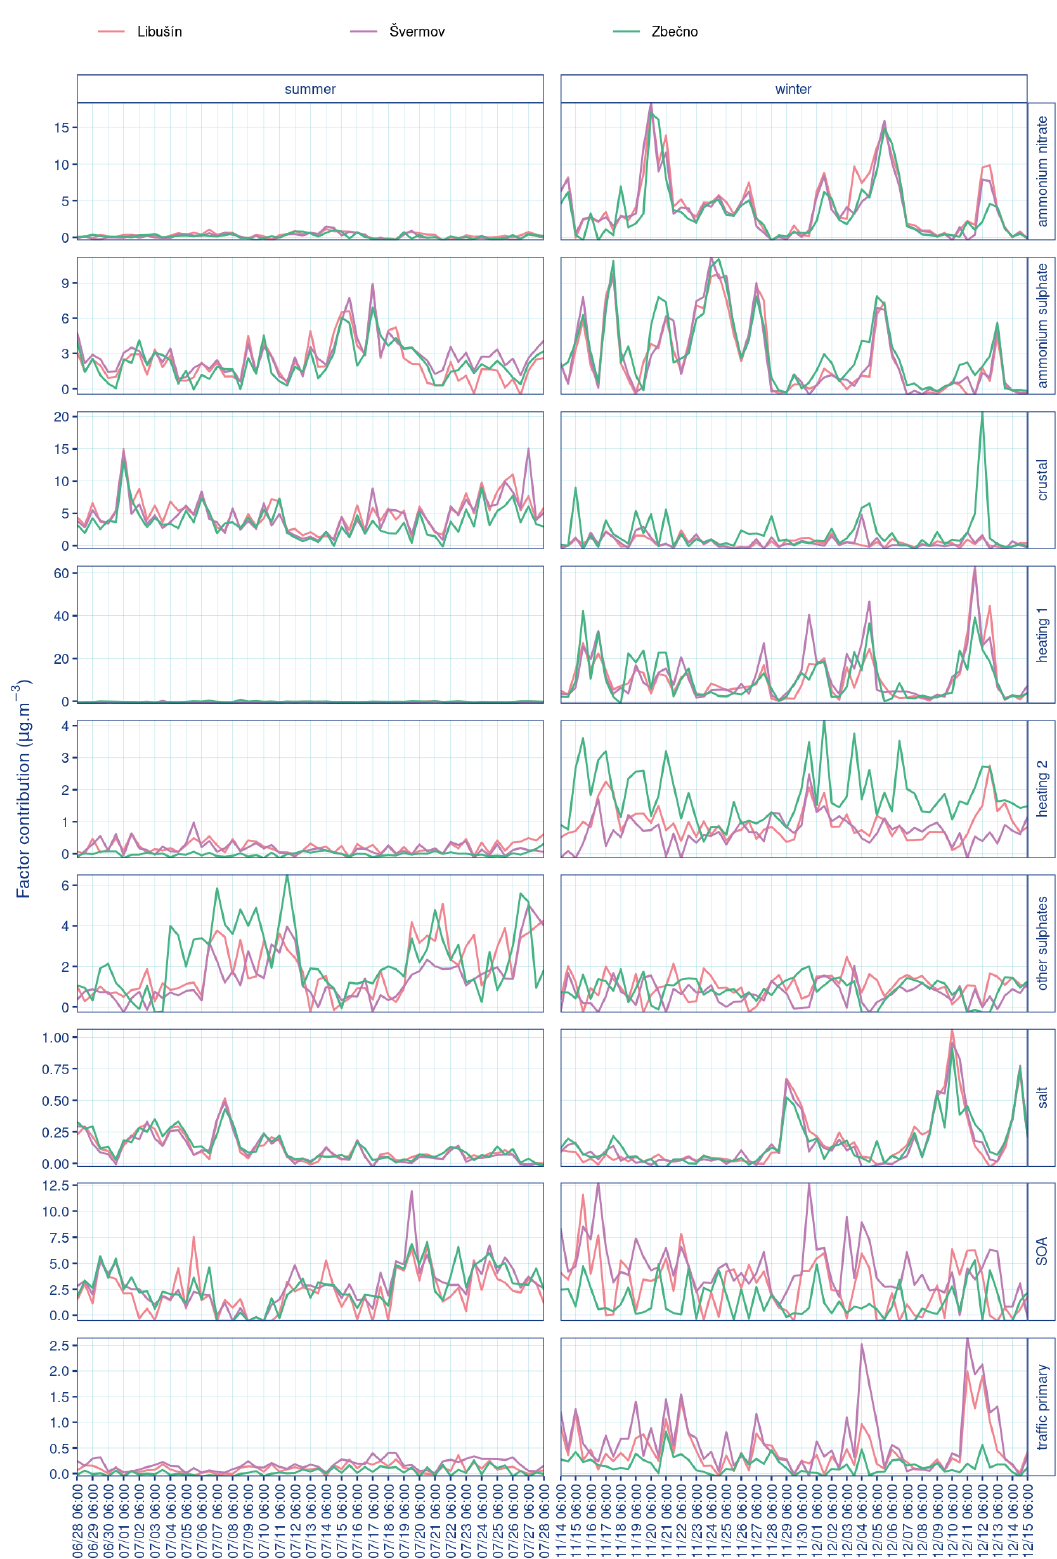
Figure A2. Factor contributions to the PM 2.5 mass concentration.